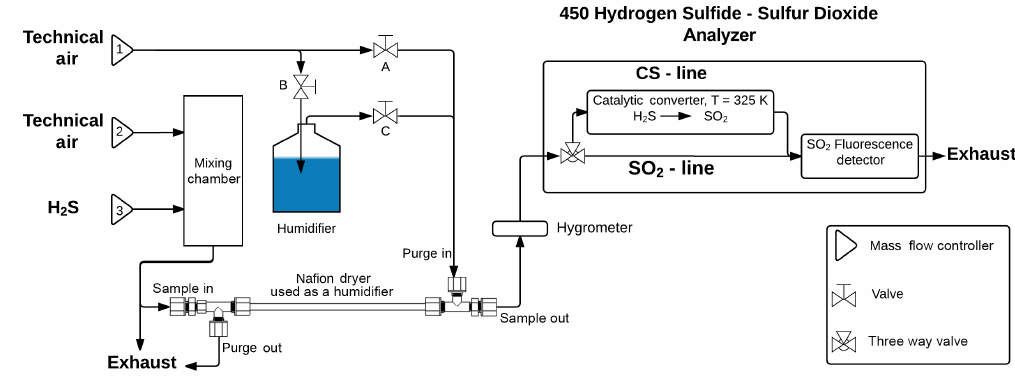
Figure 2. Schematic of the experimental setup. Table 1. List of materials and instruments used in the experimental setup.